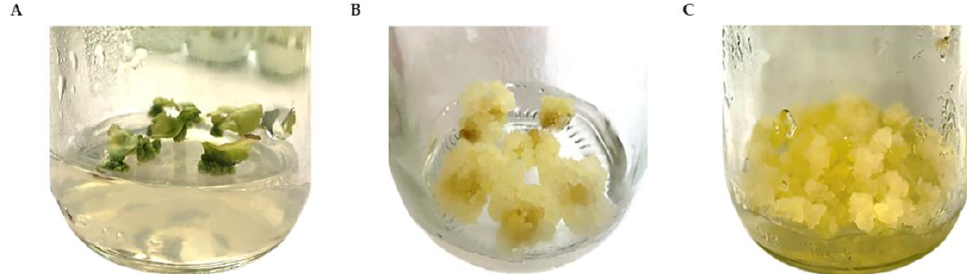
Figure 2. Callus culture of R. nasutus : ( A ) callus initiation from leaf explants after 3 weeks; ( B ) callus growth on CIM (MS medium supplemented with 1 mg/L 2,4-D and 1 mg/L NAA) after culturing for 7 days; ( C ) callus proliferation on CIM after 15 days of culture.